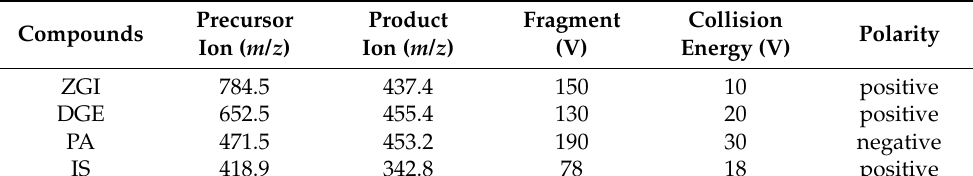
Table 8. Mass spectrometric parameters of the three compounds and IS.